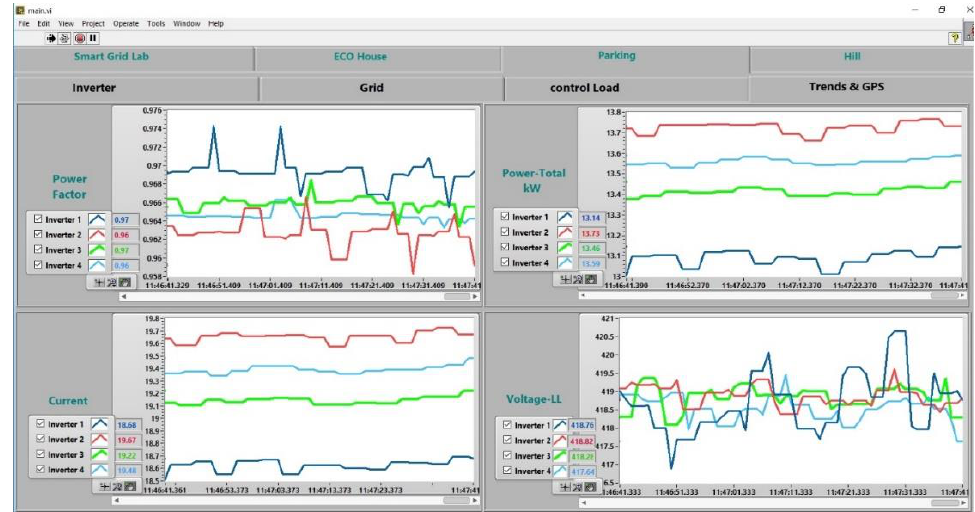
Figure 19. Time-domain plots based on the values of quantities over a period of time.